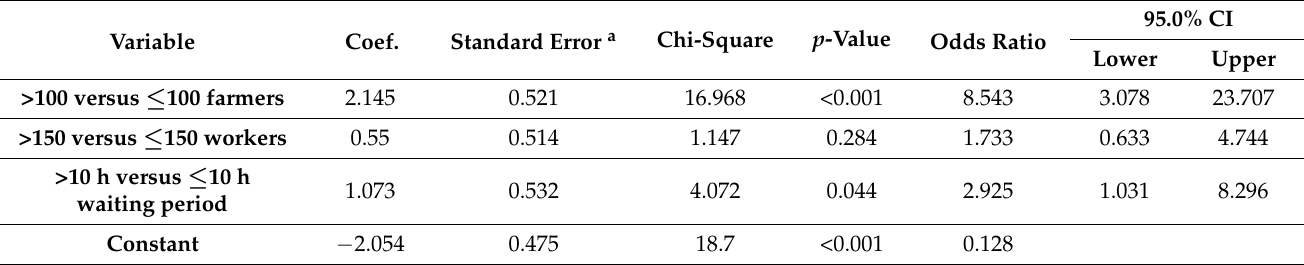
Table 3. Results of a multivariate logistic regression of risk factors for Salmonella isolation from carcasses sampled at broiler processing plants in